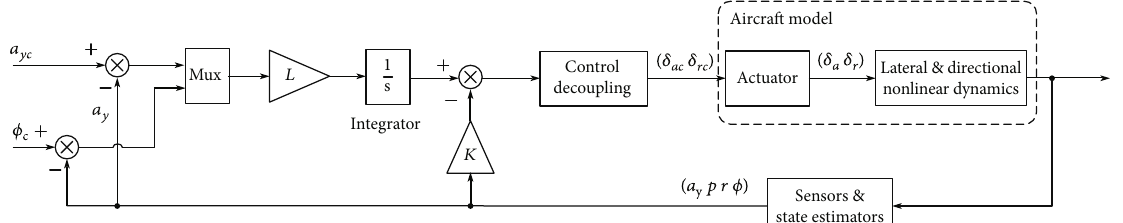
Figure 10: Lateral – directional EA control